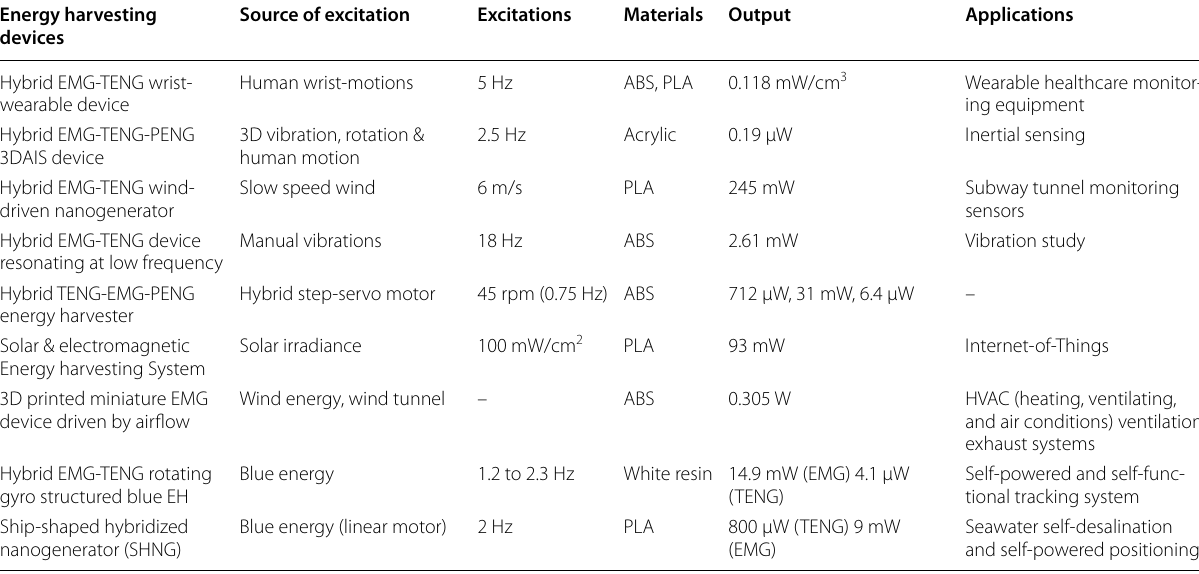
The references of the research papers cited in this table are provided in the Additional file 1 EMG electromagnetic generator, TENG triboelectric nanogenerator, PENG piezoelectric nanogenerator, 3DAIS 3D activity inertial sensor, ABS acrylonitrile poly- butadiene styrene, PLA polylactic acid, EH energy harvester